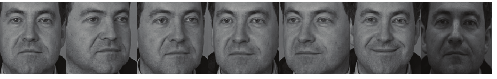
Figure 1: All images of one person from FERET database.